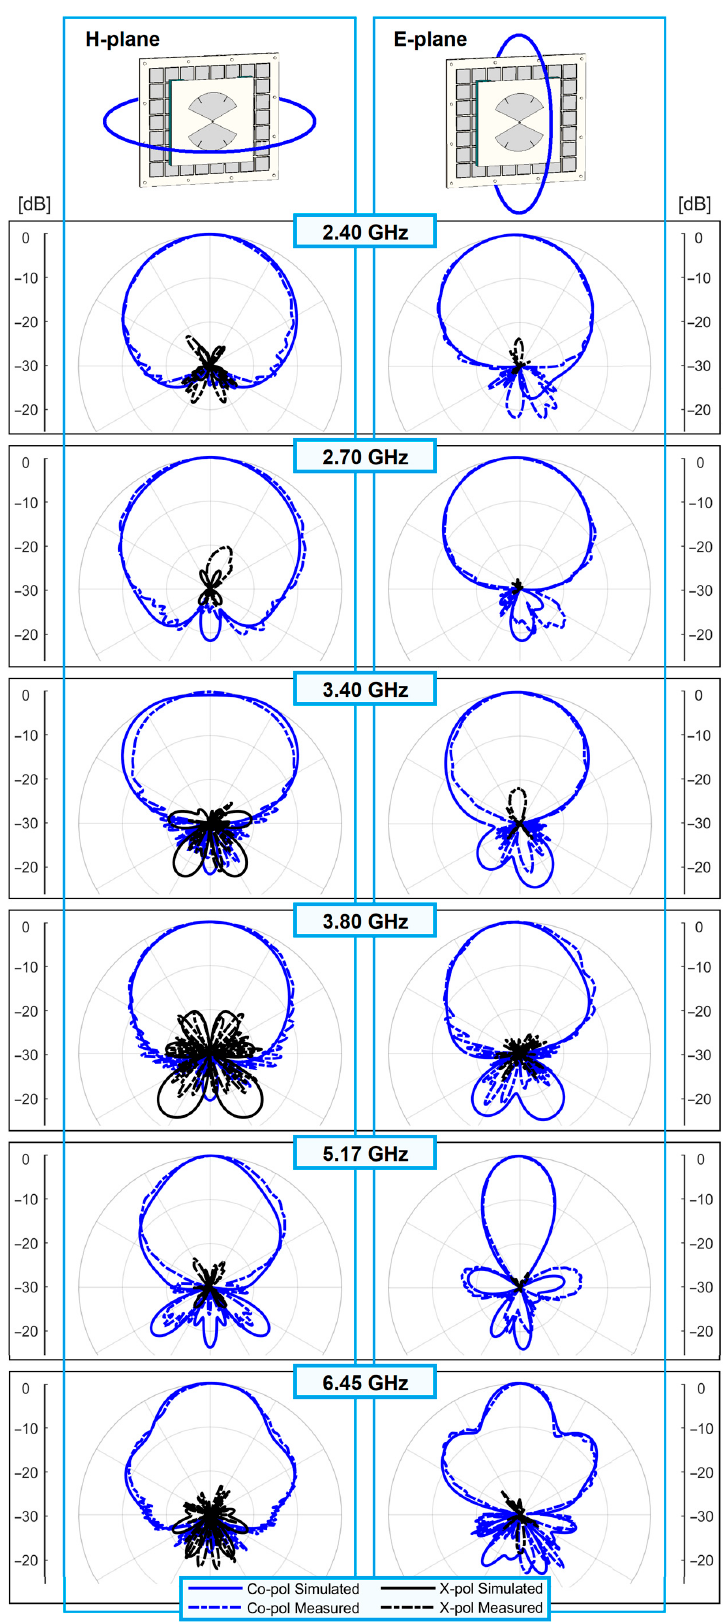
Figure 17. Radiation patterns at the limit frequencies of the LB, MB, and UB, and H- and E-planes.